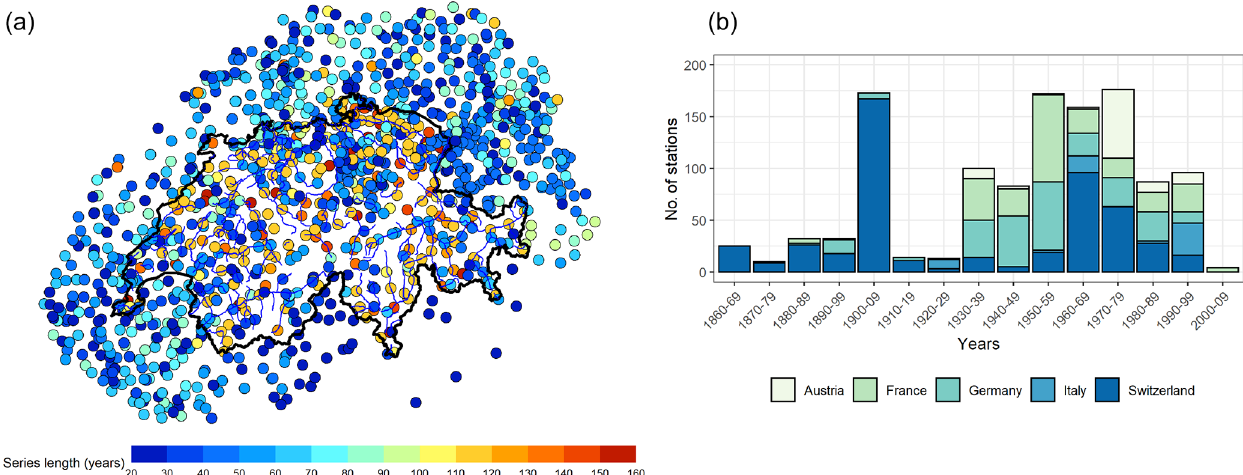
Figure 1. Description of the data used for the study. (a) Map of Switzerland and the neighboring areas showing the locations of the 1176 daily stations. The color indicates the length of the series, a minimum of 20 years and a maximum of 156 years. (b) Bar plot showing the number of stations installed in each country for each